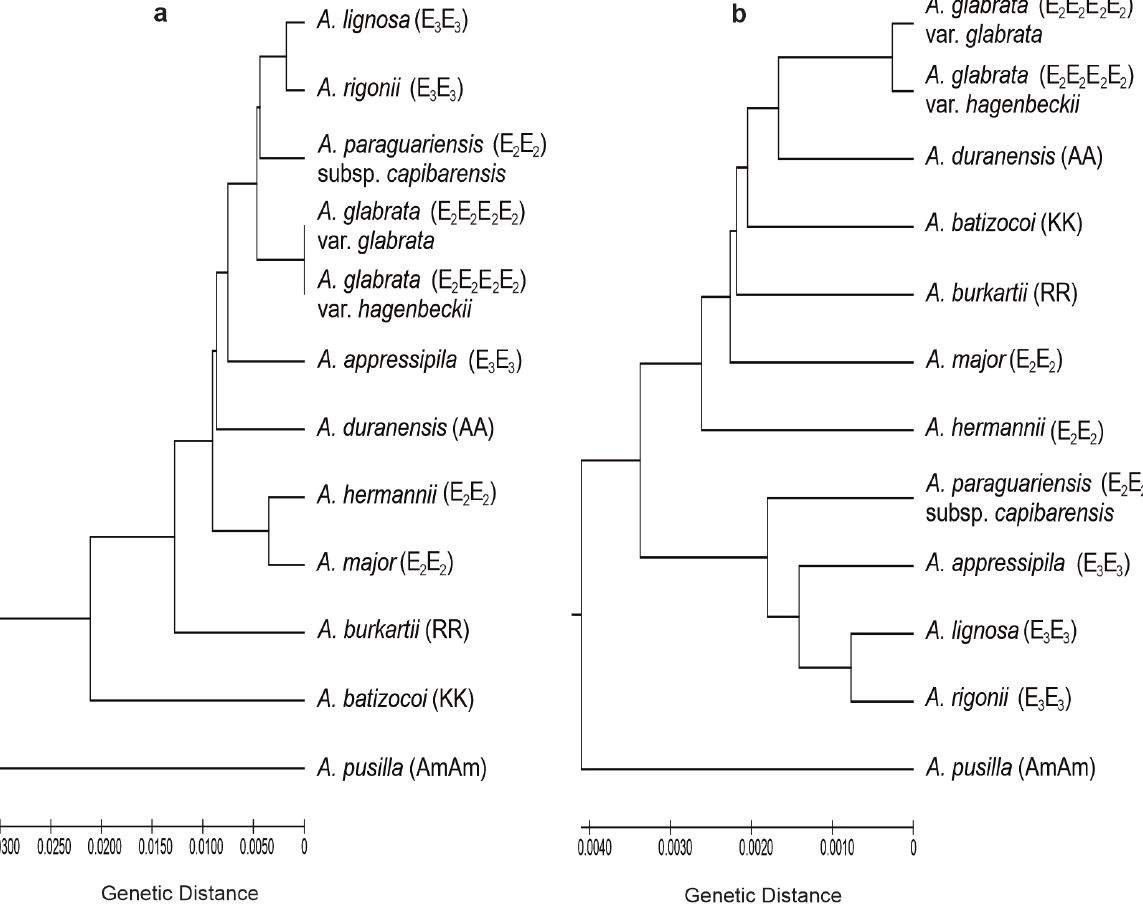
Figure 3. UPGMA dendrograms of Arachis species based on the sequences of ITS (a) and two non-coding regions ( trnT–S , trnT–Y ) of the cpDNA (b) datasets. The genomic constitution of each taxa is indicated in